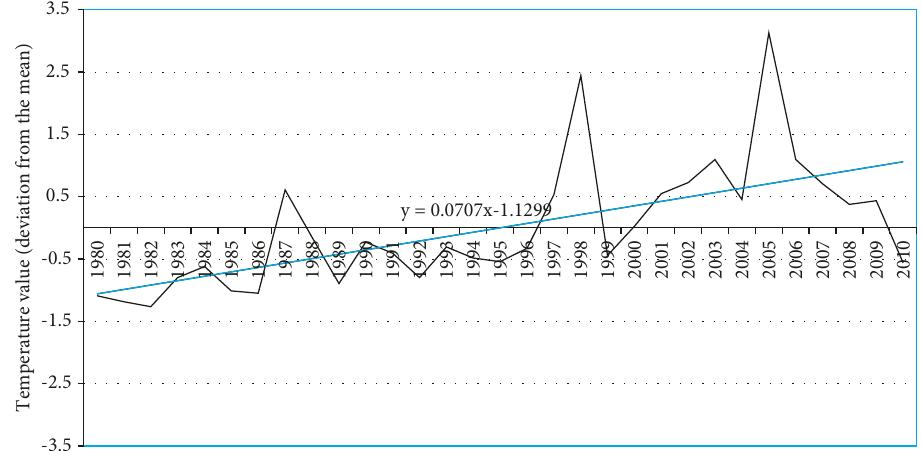
Figure 4: Temperature data deviation from the mean in Manoka over the past decades. Source: Douala Meteorological Station.